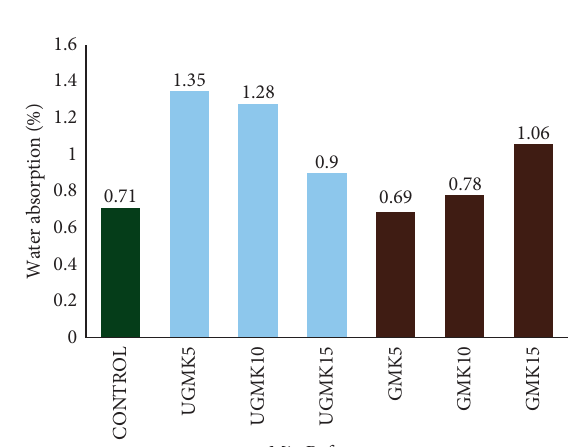
Figure 14: Sorption coefficient of GSF.